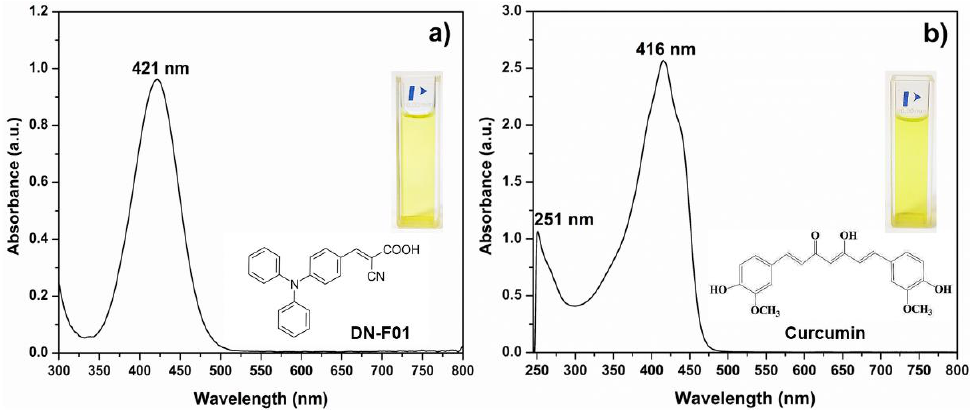
Figure 7. UV-Vis absorption spectra of ( a ) DN-F01 dye and ( b ) curcumin dye in ethyl acetate.